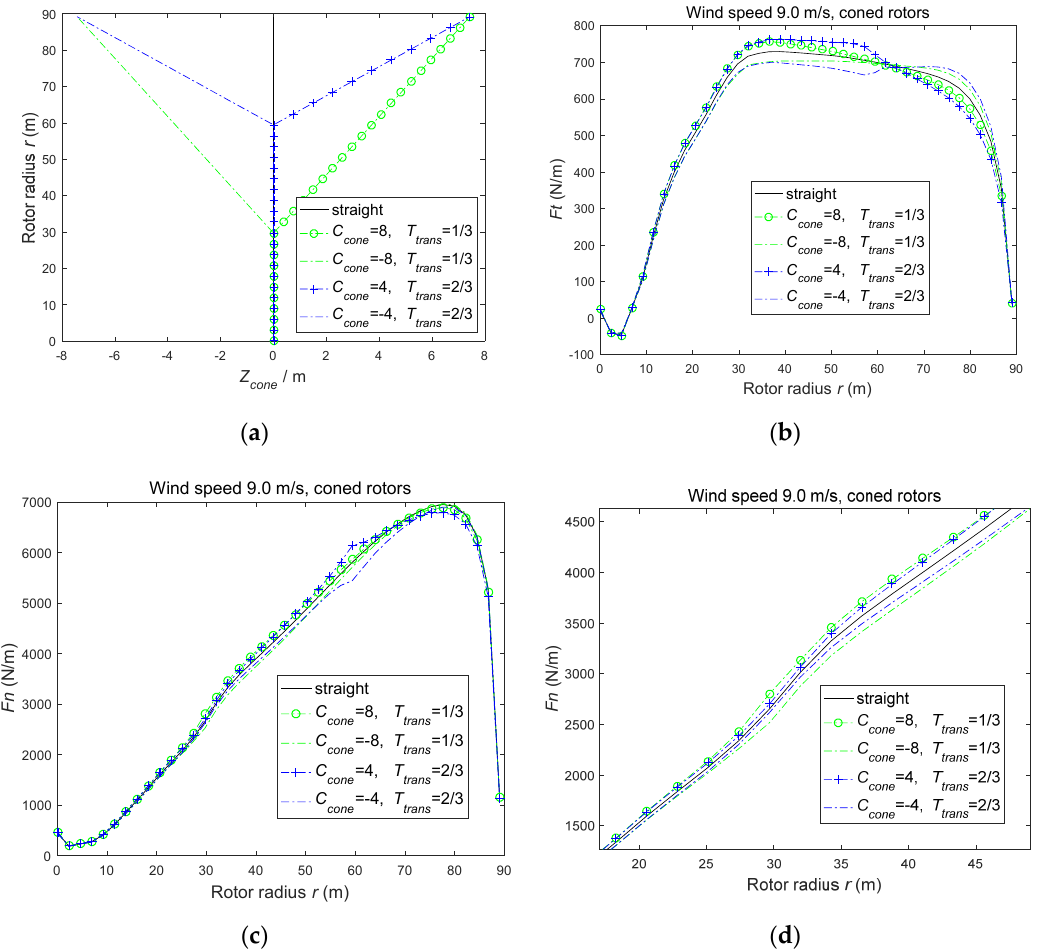
Figure 11. Comparisons of rotors with the same tip location: ( a ) conning configurations; ( b ) tangential force; ( c ) normal force; ( d ) magnified view of the normal force.